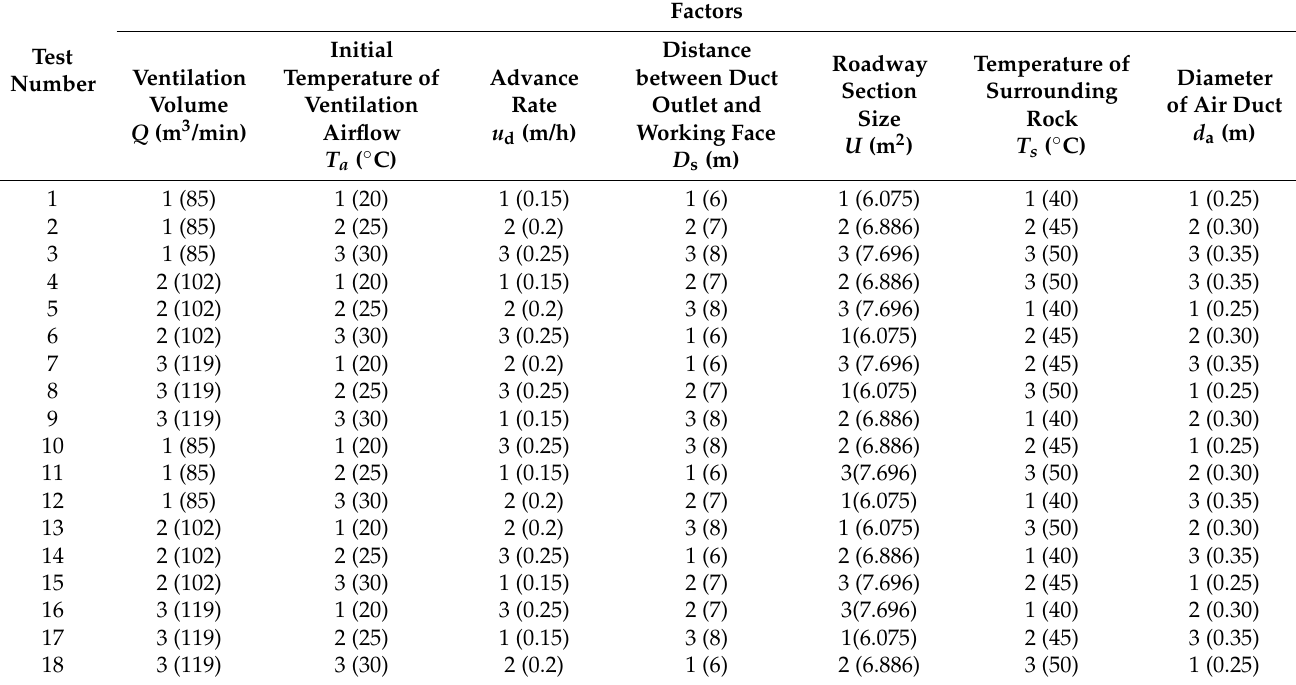
Table 2. U 18 *(3 7 ) orthogonal